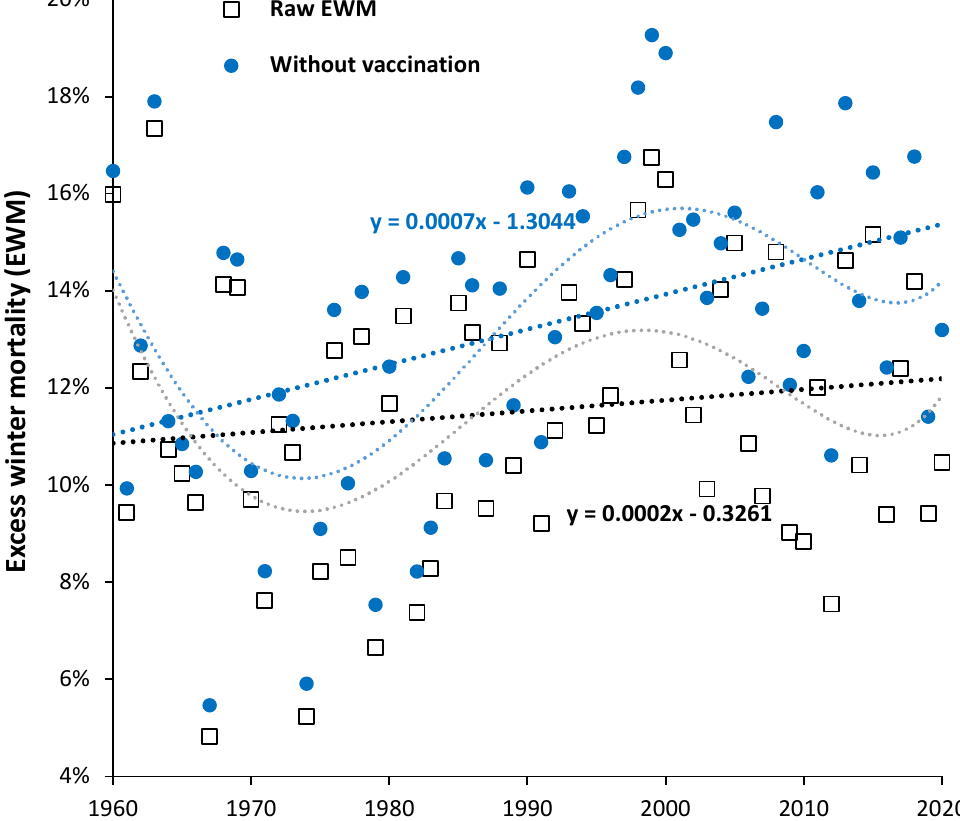
Figure 7. Trend in excess winter mortality (EWM) in the USA from 1960 to 2020, with and without correction for the effect of influenza vaccination. Vaccine effectiveness before 2003/04 estimated at 40%, actual VE values for 2003/04 onward [54]. Percent elderly vaccinated increases from around 15% in the early 1960s [28] rising to 67% to 70% from 2001 onward [29–33]. As can be seen there is indeed a trend upward in EWM since the 1960s (0.02% per annum) and that this trend would be around 3-times higher (0.07% per annum) if there were no influenza vaccination. The two dotted lines are 5th order polynomial curve fits (see Section 5.7) to show that the fundamental trends are probably far more complex, how-